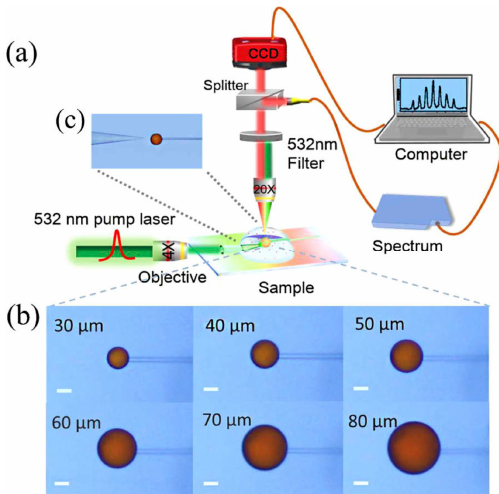
Figure 2. ( a ) Schematic diagram of the whispering gallery mode (WGM) experimental platform. ( b ) Micrographs of the stearic acid-doped 5CB microdroplets with different diameters. ( c ) Micrograph of microdroplet excited by a fiber tip positioned correctly within its vicinity. Reproduced from [36].